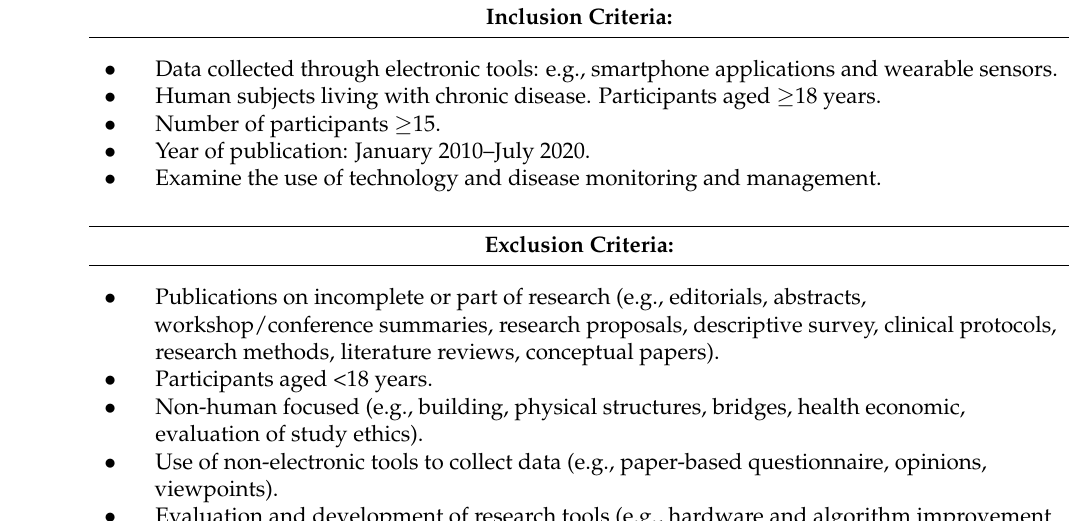
Table 1. Selection criteria for review articles (adapted from reference